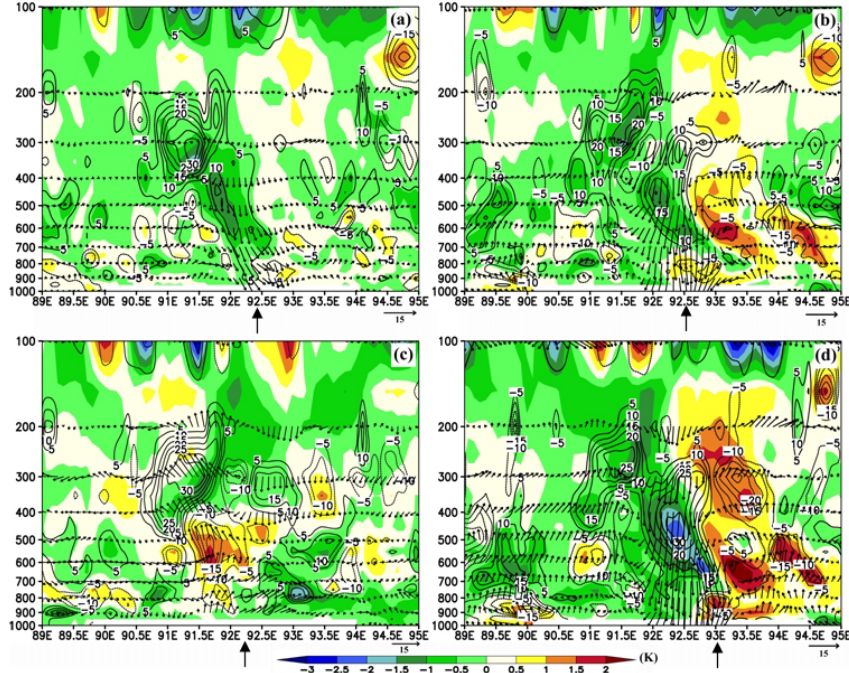
Figure 7. Vertical section of differences (VAR − CTL) in the distribution of temperature (shaded), humidity (contours; gkg − 1 ) and wind (vectors; ms − 1 ) patterns in (a) VARAMV, (b) VARPREP, (c) VARRAD and (d) VARPREP + RAD for Phailin at 12:00UTC 9 October 2013. The arrow on the horizontal axis of each panel indicates the longitude position of cyclone for the corresponding